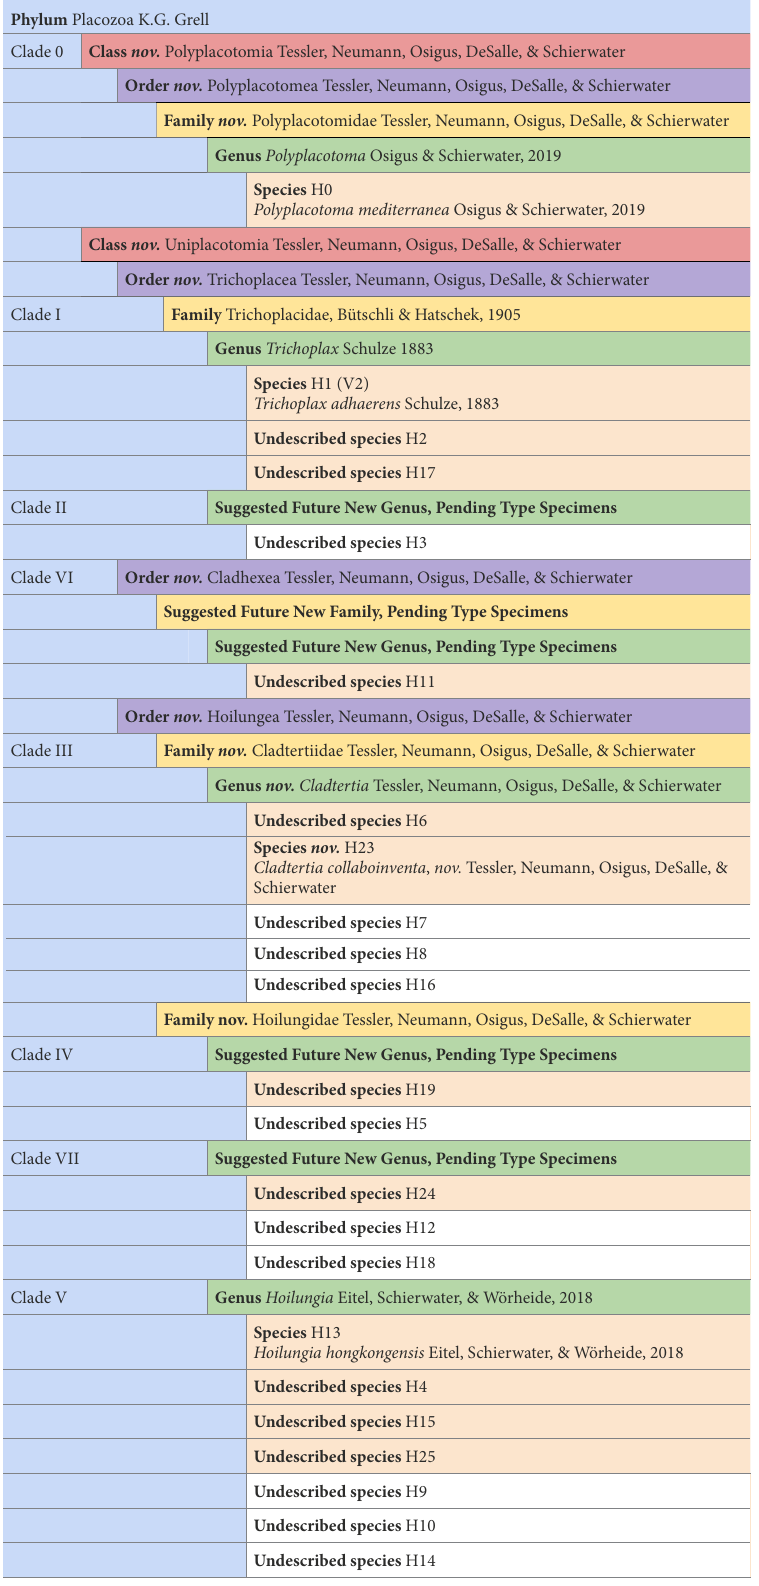
TABLE 3 The first fully fleshed-out taxonomy for the phylum Placozoa. Phylum Placozoa K.G.